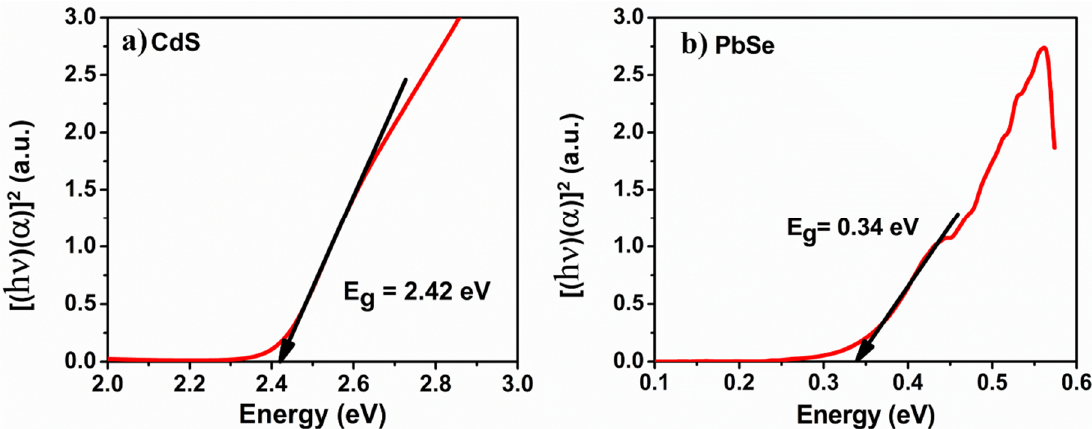
Figure 5. Energy direct bandgap calculated by Tauc procedure for each involved material of the heterojunction: ( a ) CdS; and ( b ) PbSe.